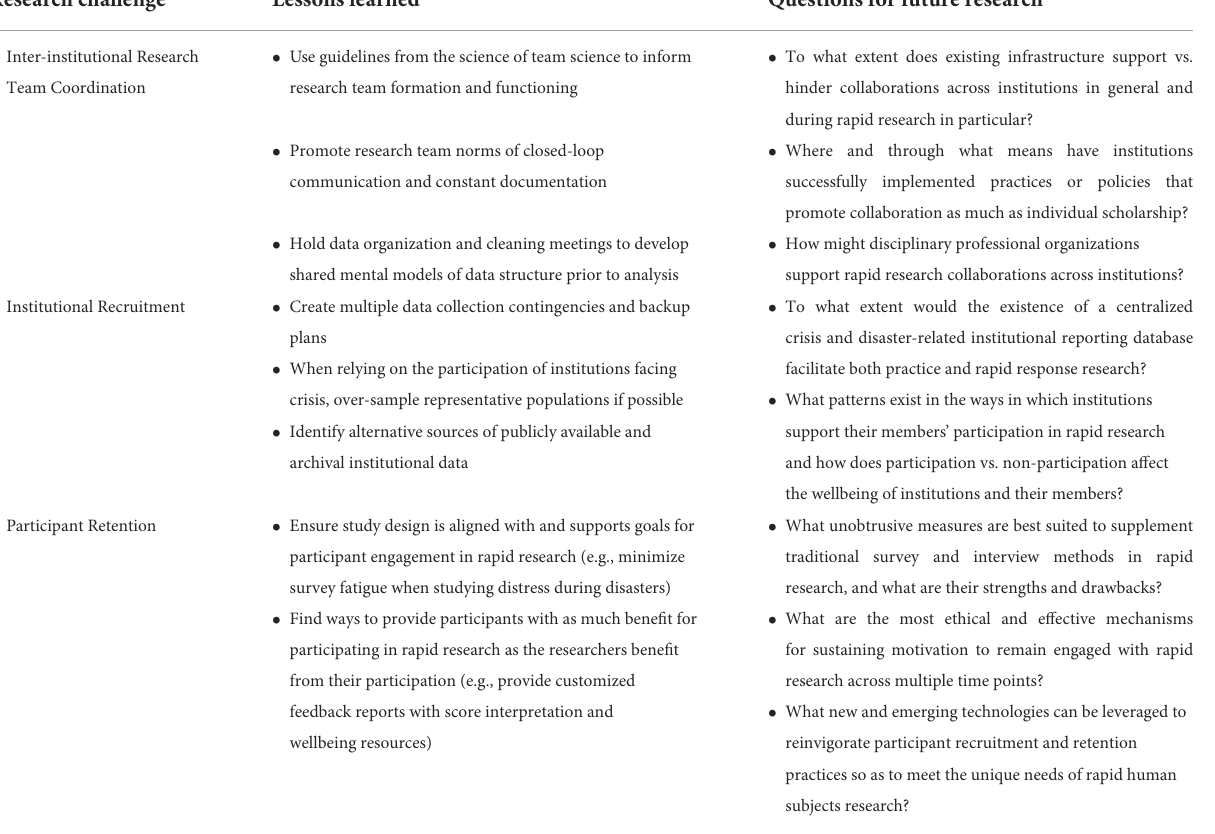
TABLE 1 Future rapid response human subjects research